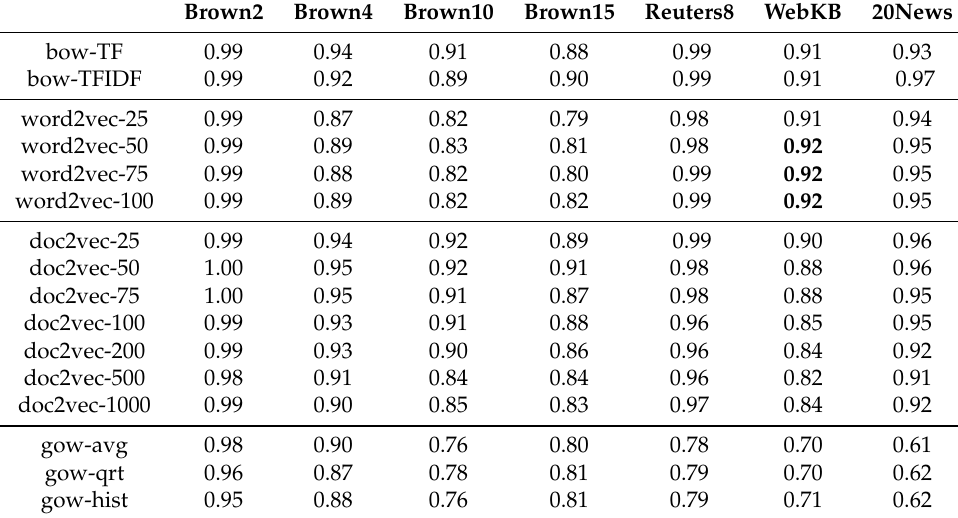
Table 4. Macro-averaged area under the receiver-operating curve (AUROC) of the 16 variants of the document representation models on the seven classification tasks. The top-performing models for each task are shown in